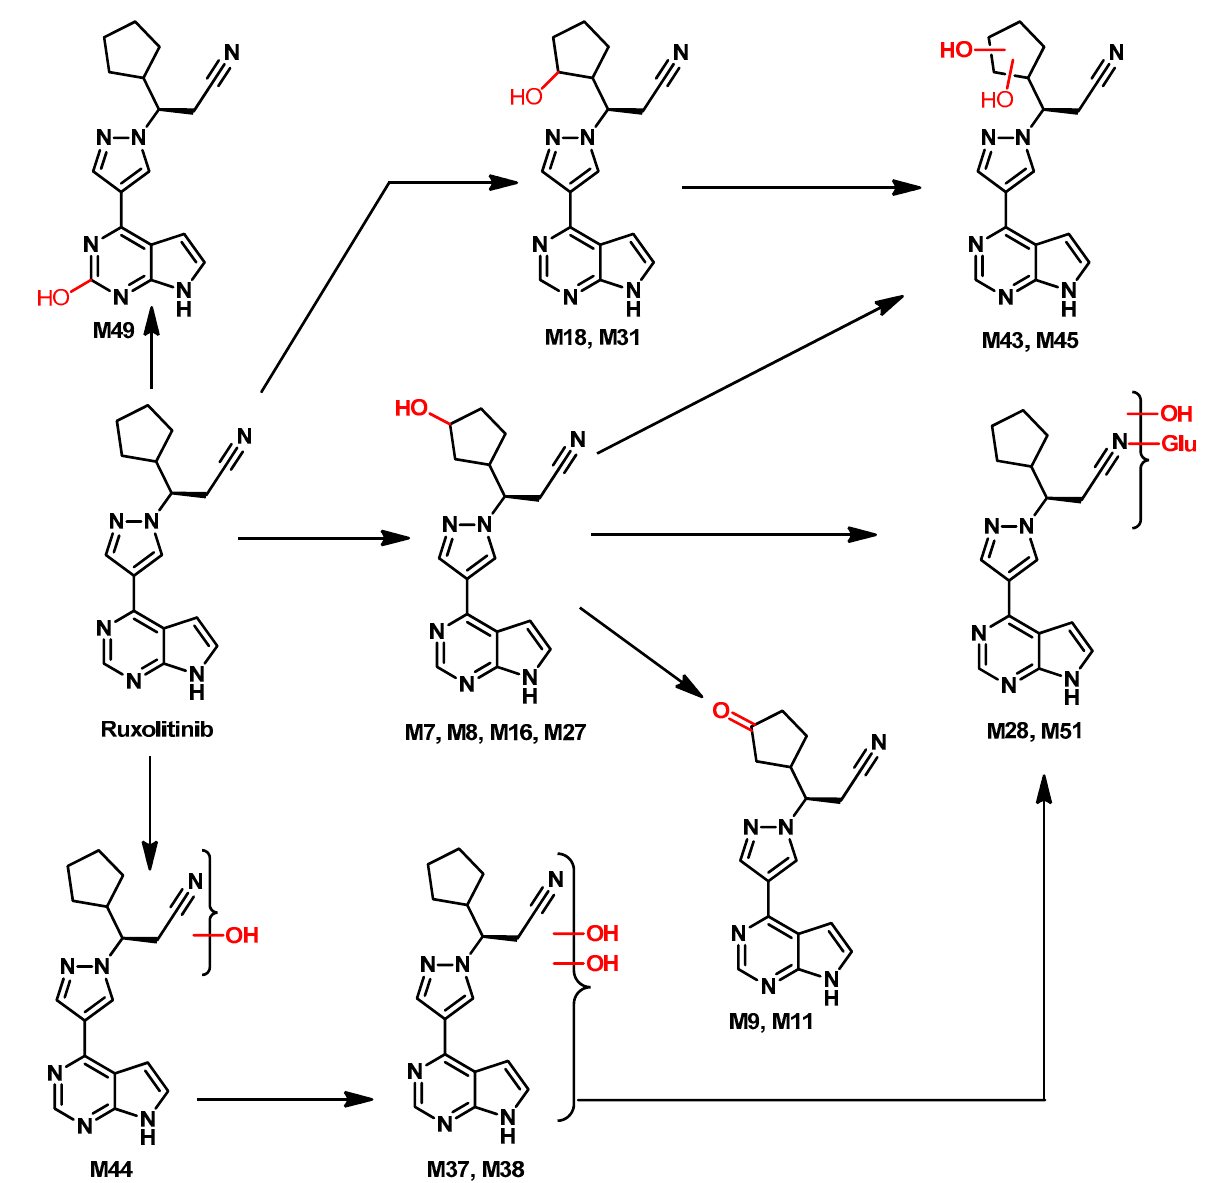
Figure 57. Proposed metabolic pathways and metabolites of ruxolitinib in humans.